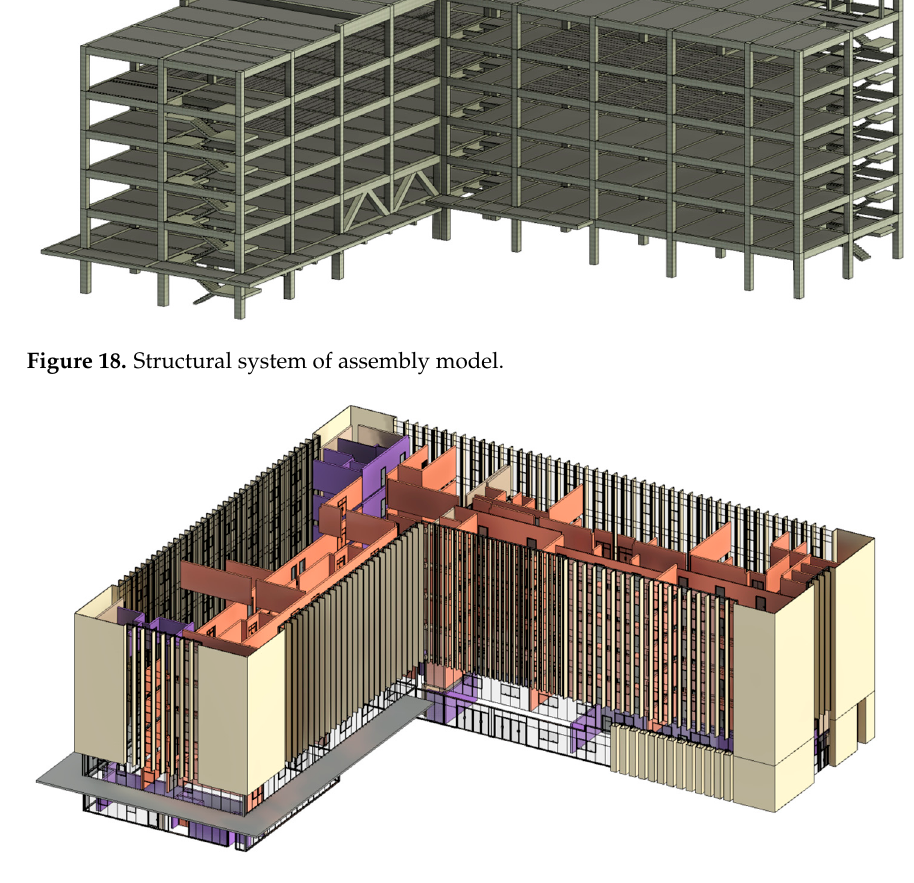
Figure 19. Maintenance System of assembly model. Table 6. Example of assembled model extended component entities and property